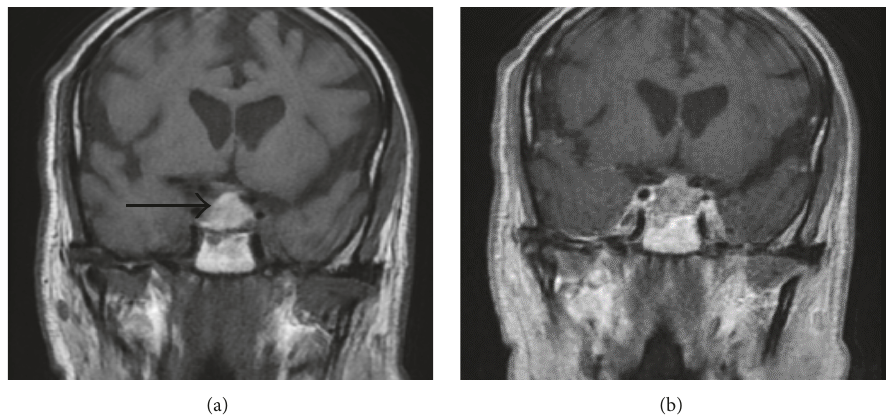
Figure 1: Brain MRI W/WO contrast 2 days before surgery. (a) Coronal T1-weighted image demonstrates a large sellar mass with suprasellar extension and slight mass effect on the optic chiasm. This mass exhibits marked hyperintense signal on T1-weighted image (arrow), which indicates blood products and recent hemorrhage. (b) Coronal T1-weighted postcontrast image shows normal enhancement of the cavernous sinus. No enhancing mass or nodule is evident in association with intrinsically T1 bright lesion. The mass abuts approximately 90 degrees of the right internal carotid artery contour. This abutment is less on the left side. The carotid arteries are patent and show normal caliber without any narrowing. No normal pituitary tissue is